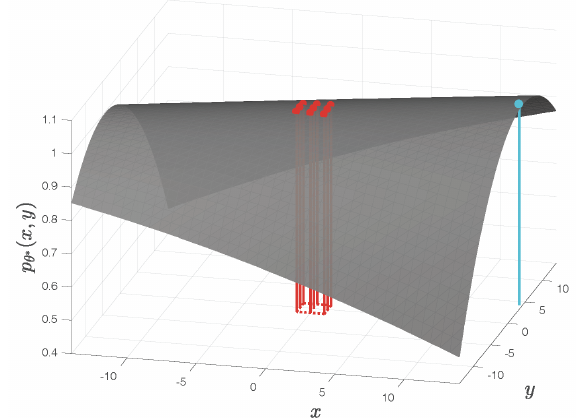
Figure 7. Two images of the moon, the same as in Figure 5, but with a different template choice shown by the red windows.